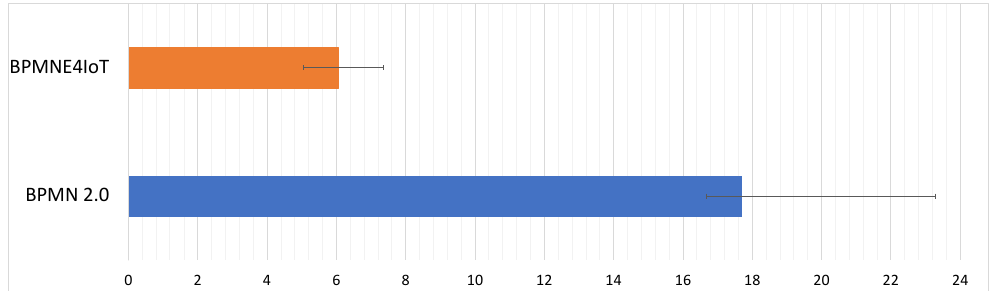
Figure 20. Means and standard deviation of task completion time in minutes.